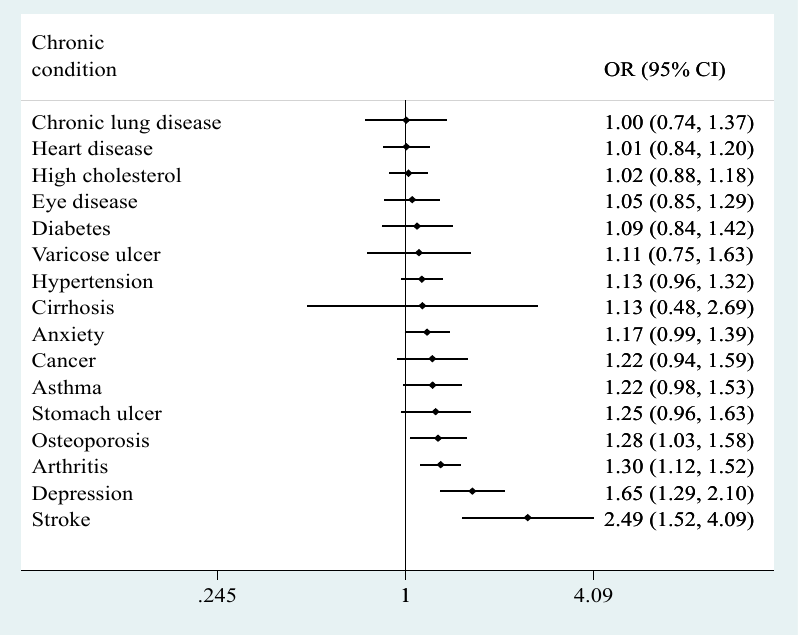
Table 3. Mediating variables in the prospective association between multimorbidity (i.e., ≥ 2 chronic conditions) at baseline and falls at follow-up. Total Effect